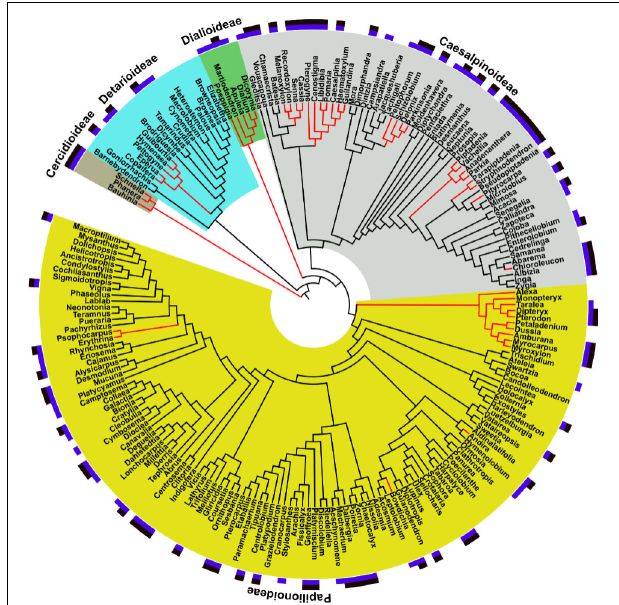
FIGURE 3 | Distribution of medicinal uses and pharmacological studies in the Leguminosae phylogeny and “Hotnode clades” for ethnomedicinal use. Block colors at the tips: purple, ethnomedicinal use for that genus; black, pharmacological studies for that genus. Branch colors: red branches, genera present in hotnode clades for species with ethnomedicinal use. Clade colors: yellow, grey, green, light blue and brown indicate membership of subfamilies. Figure prepared using iTOL online (Letunic and Bork, 2016).